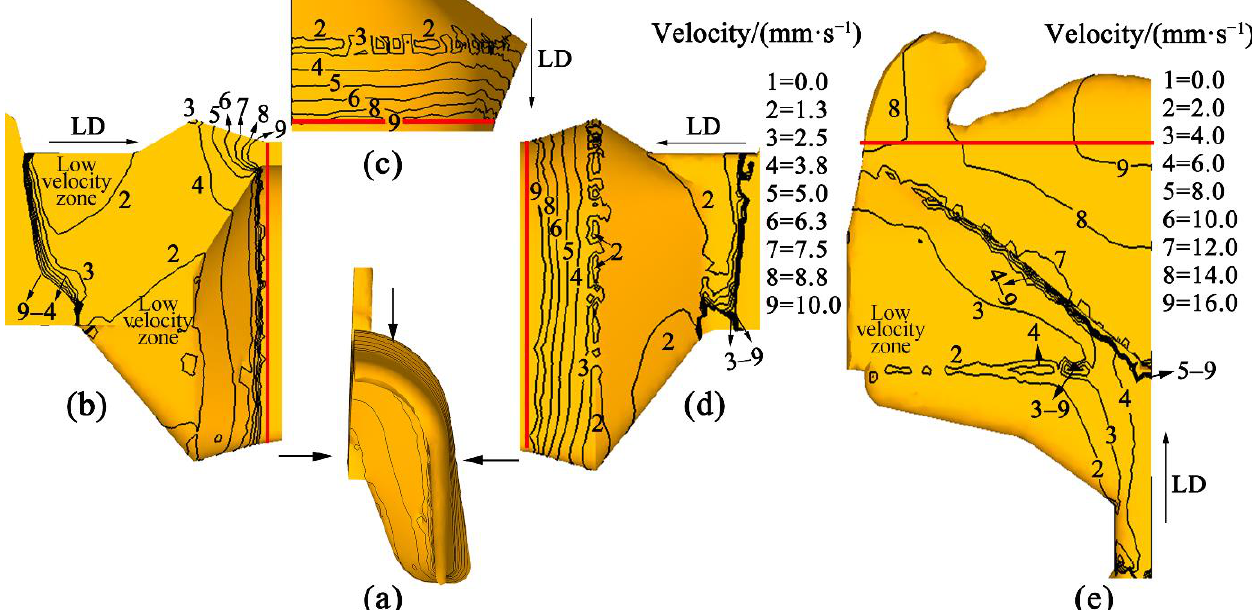
Figure 6. Distribution of velocity in the chamber and die: ( a ) U-Shaped strips; ( b ) On the symmetry plane of U-Shaped strips; ( c ) Planform of U-Shaped strips; ( d ) Right elevation of U-Shaped strips; ( e ) Planform of flat strips.